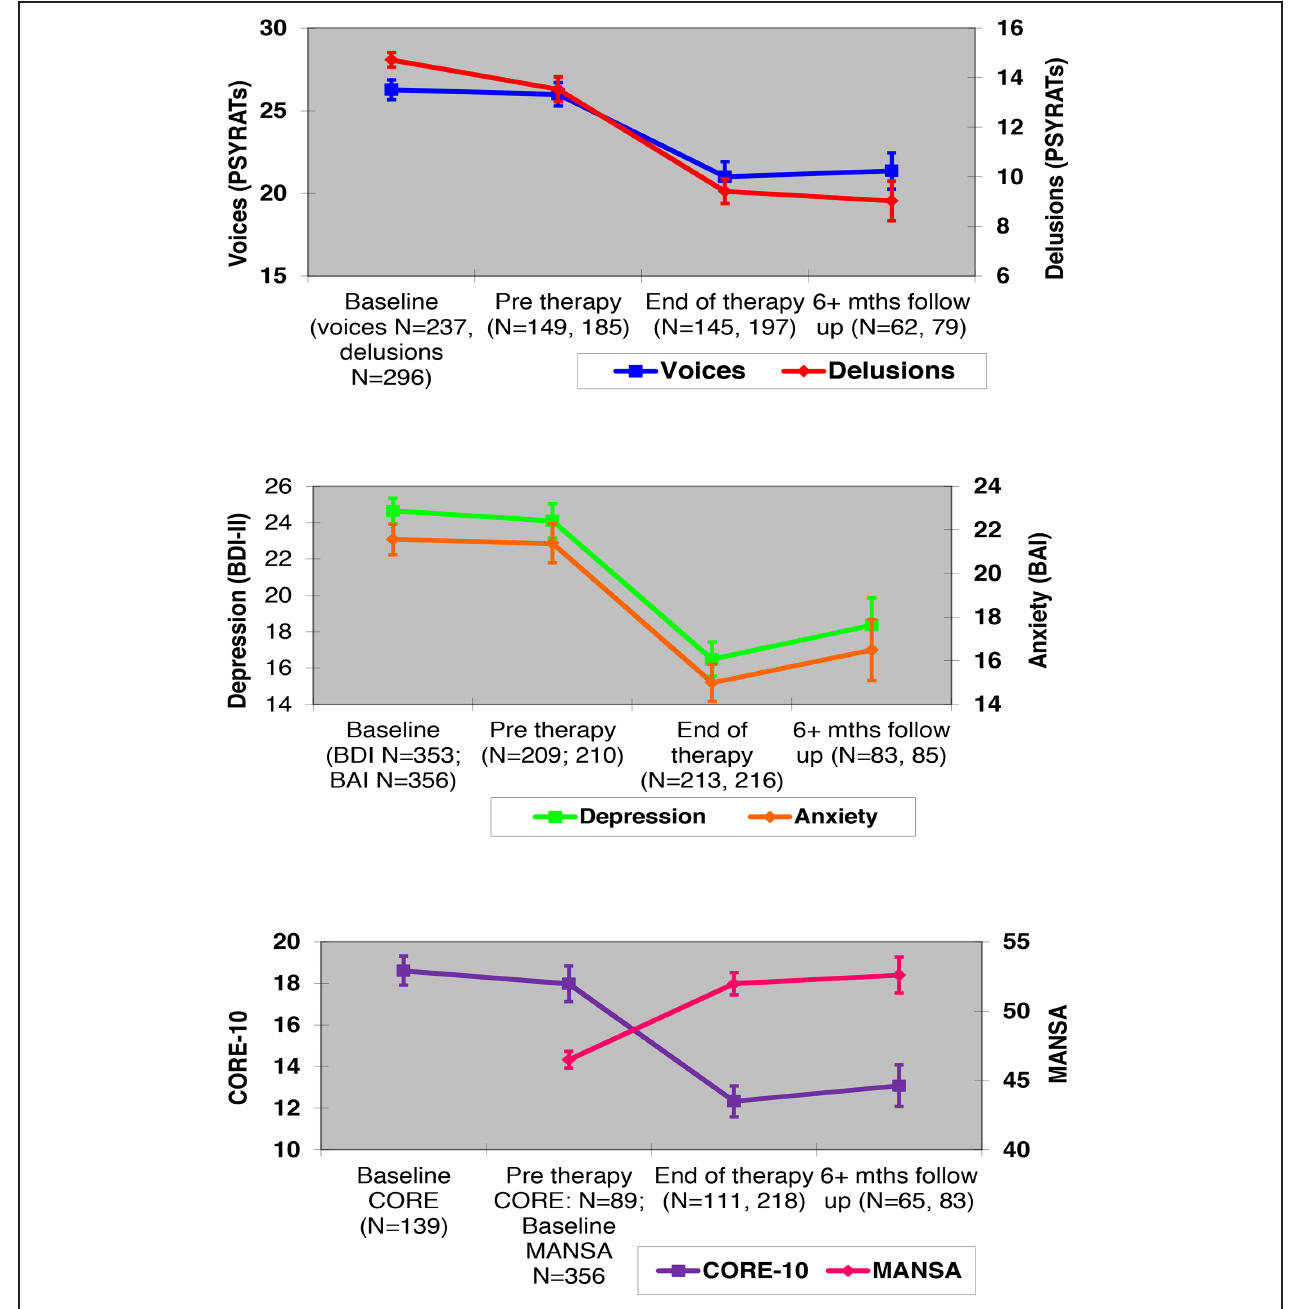
FIGURE 2 | Means (with standard errors) of clinical outcomes at each assessment time-point. PSYRATs, Psychotic Symptom Rating Scales (Haddock et al., 1999). BDI-II and BAI, Beck Depression Inventory-II (Beck et al., 1996) and Beck Anxiety Inventory (Beck and Steer, 1990). CORE-10, Clinical Outcomes